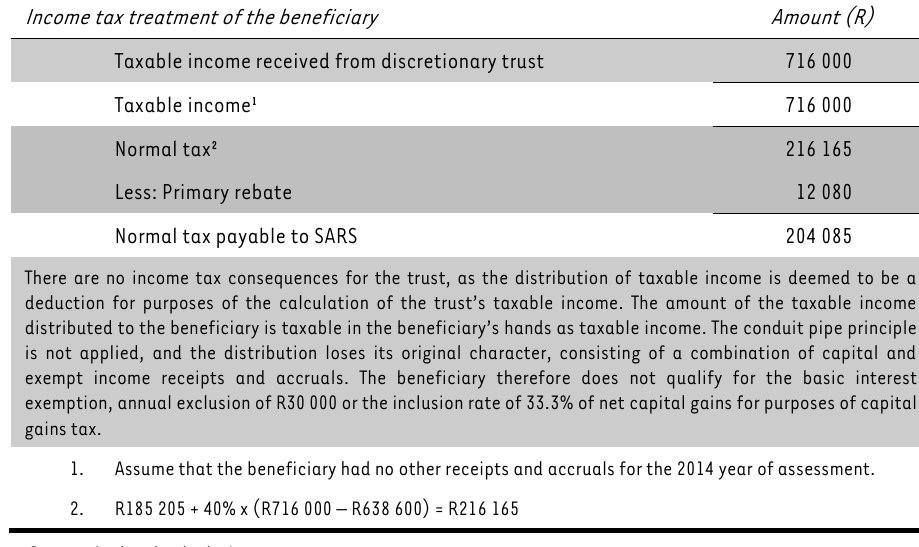
Proposed income tax treatment of the beneficiary – all receipts and accruals vest